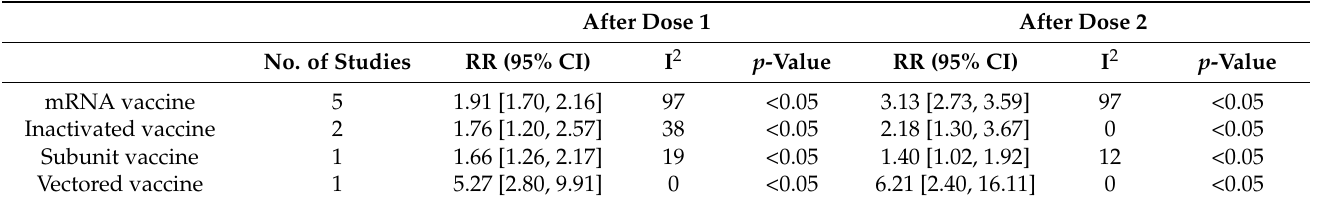
Table 5. Overall specific adverse reactions among the vaccination group versus the control group after dose 1 and dose 2. After Dose 1 After Dose